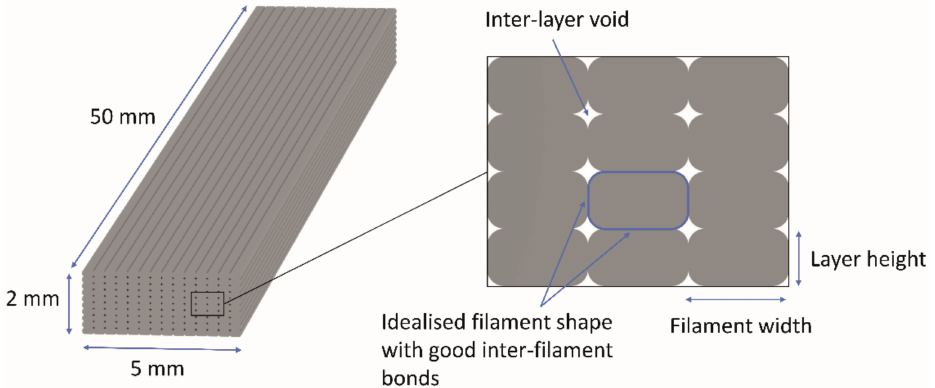
Figure 2. Scheme of theoretically ideal filament